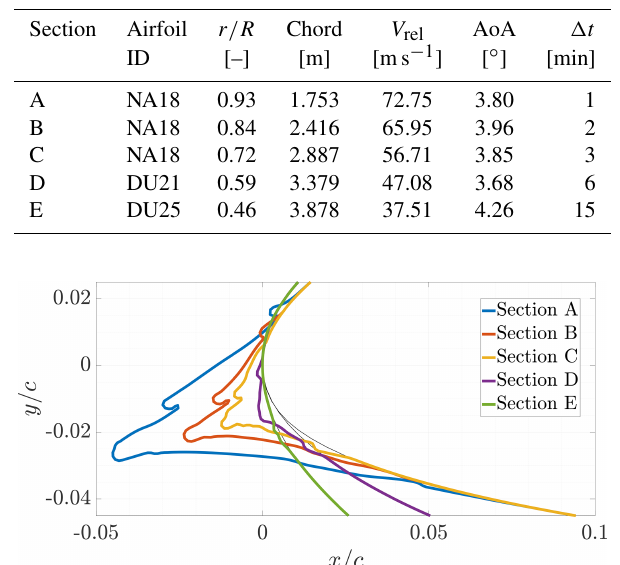
Figure 14. Non-dimensional comparison of the ice shapes on Sec- tions A–E.